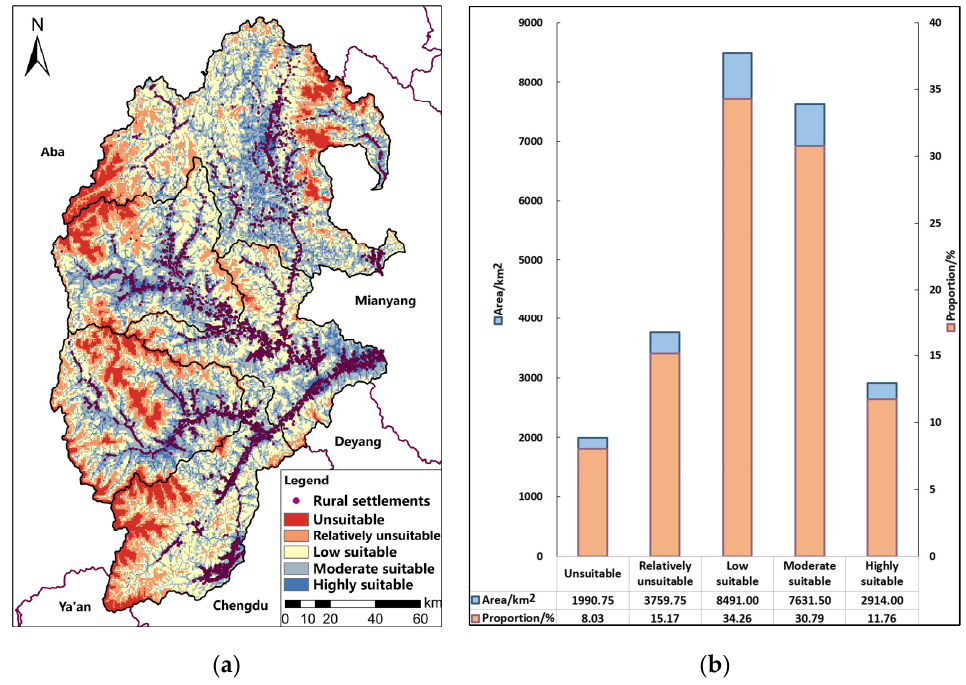
Figure 4. Livability of Rural Settlements in the Upper Reaches of the Minjiang River. ( a ) Comprehensive Livability Classification; ( b ) Livability Classification Statistics.